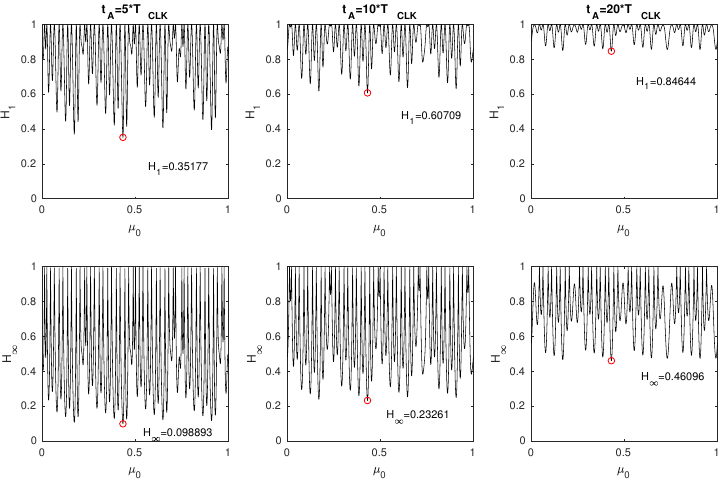
Figure 11: The estimated H 1 and H ∞ for different accumulation time.